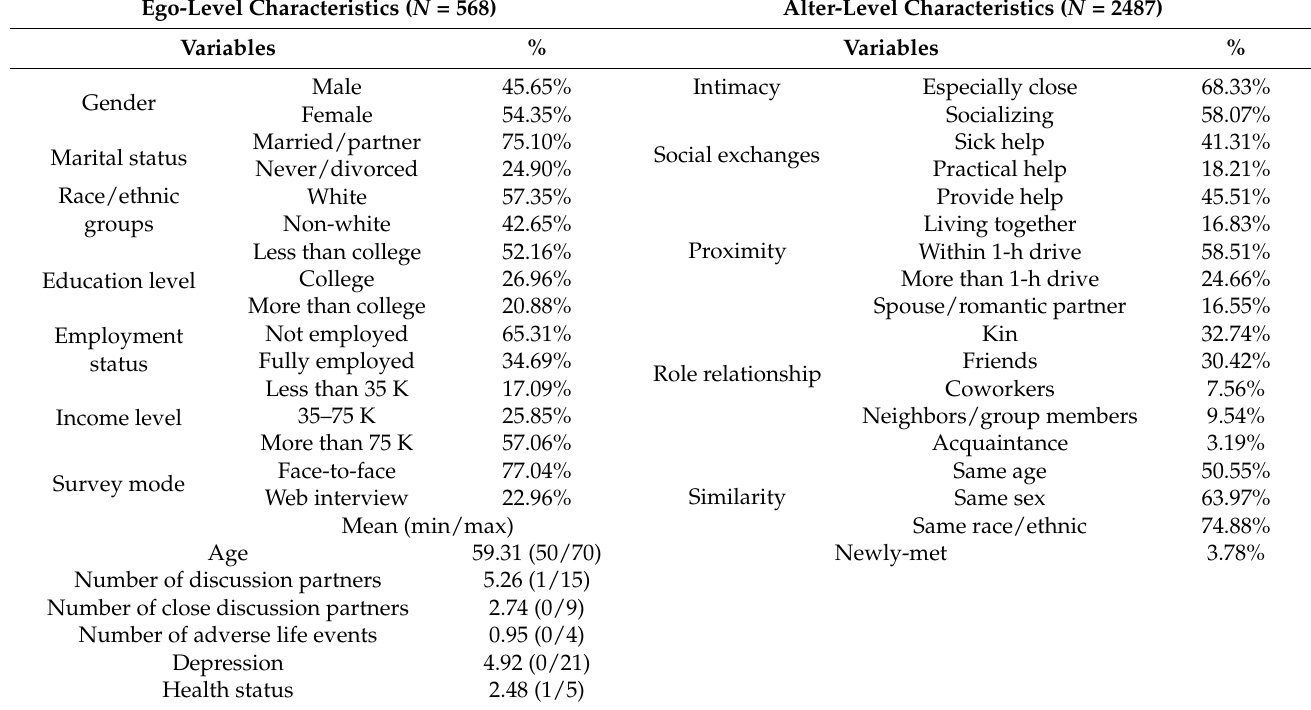
Table 1. Descriptive